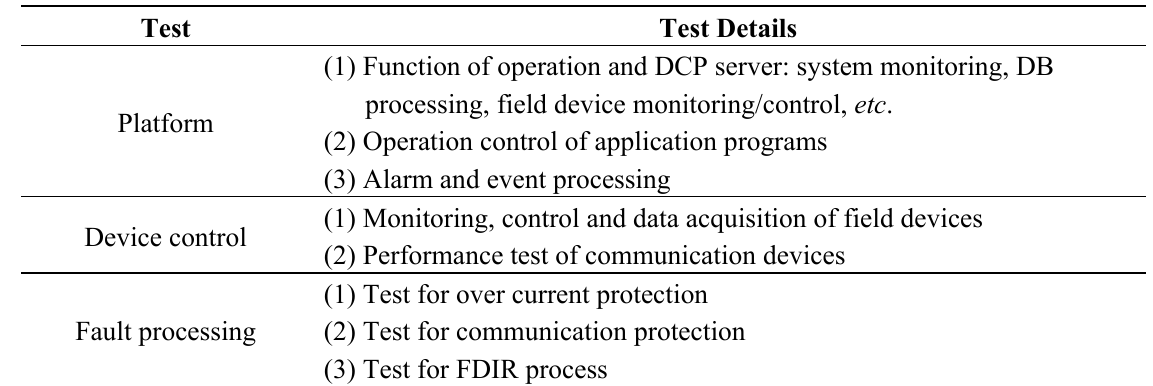
Table 10. Field tests of Gochang PTC.